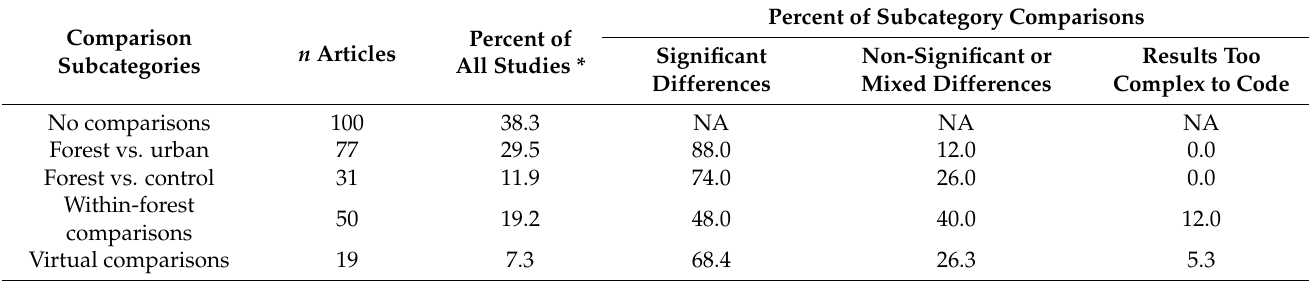
Table 6. Forest outcome comparisons made by studies in the article